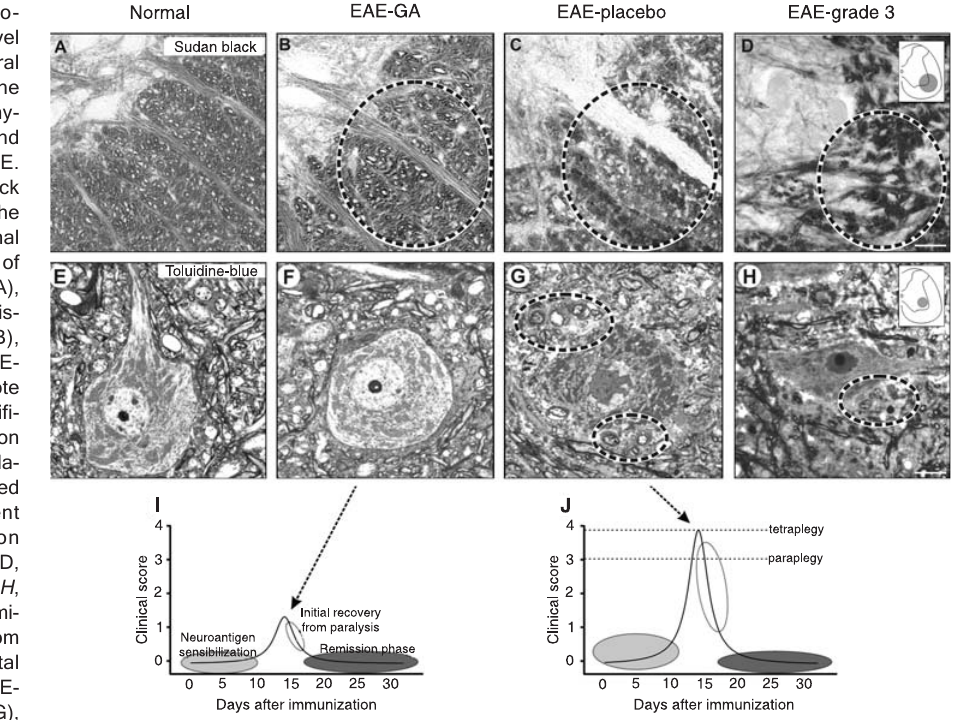
paralysis.Figure 2Figure 2Figure 2Figure 2Figure 2. Quantitative evaluation of the immunoreactivity under the different experimental conditions, demonstrating the mainte- nance of synaptic activity after GA treatment. GA treatment significantly decreased the astroglial response in the lumbar spi- nal cord, when compared to control groups. EAE = experimental autoimmune encephalomyelitis; GA = glatiramer acetate; grade 3 = hind leg paralysis. *P < 0.05 (Student